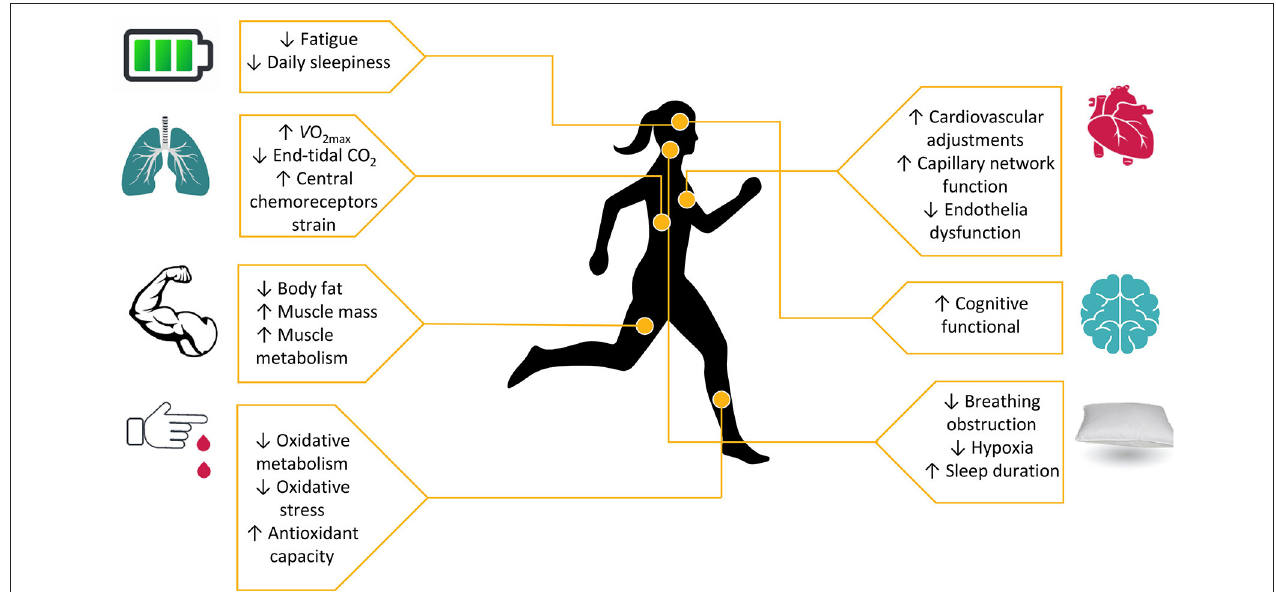
FIGURE 1 | Exercise as a regulation tool to cardiopulmonary, metabolic and cognitive disorders in sleep